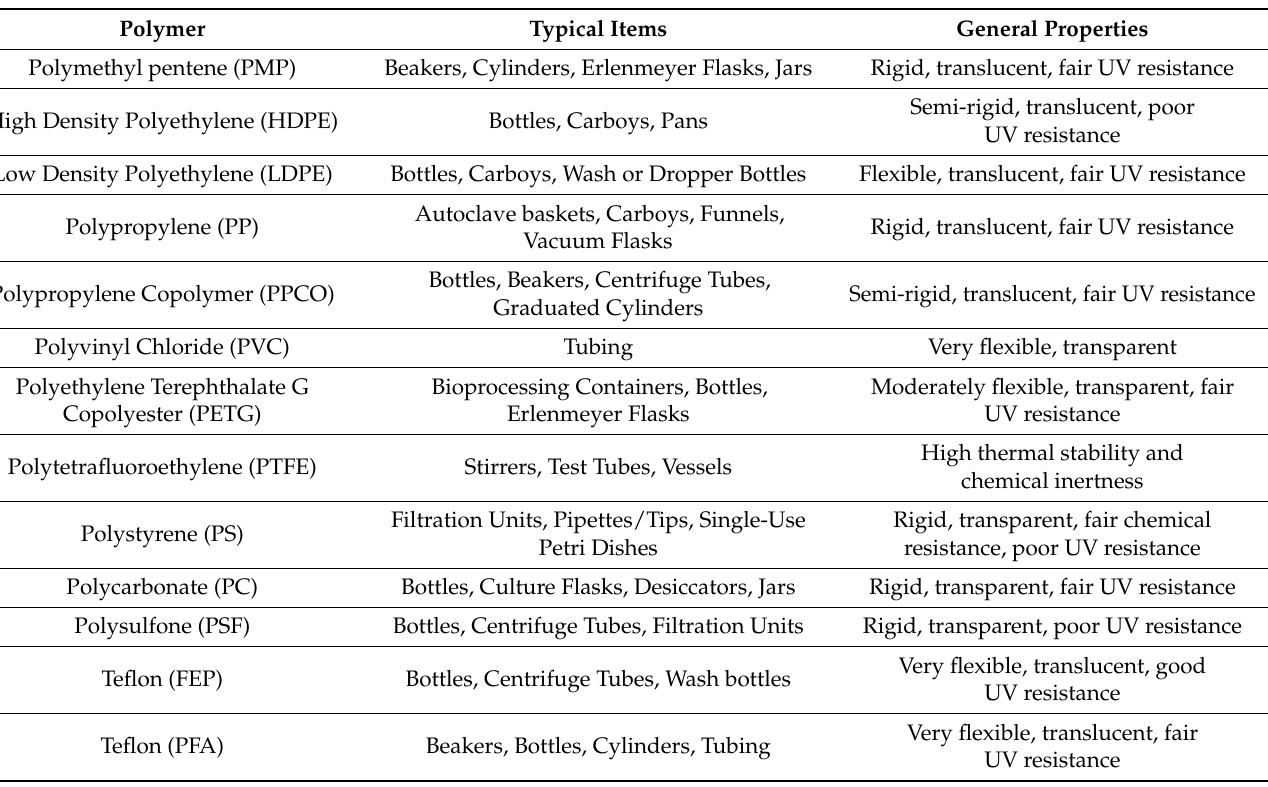
Table 1. Summary of common lab ware plastics, their typical items, and their general